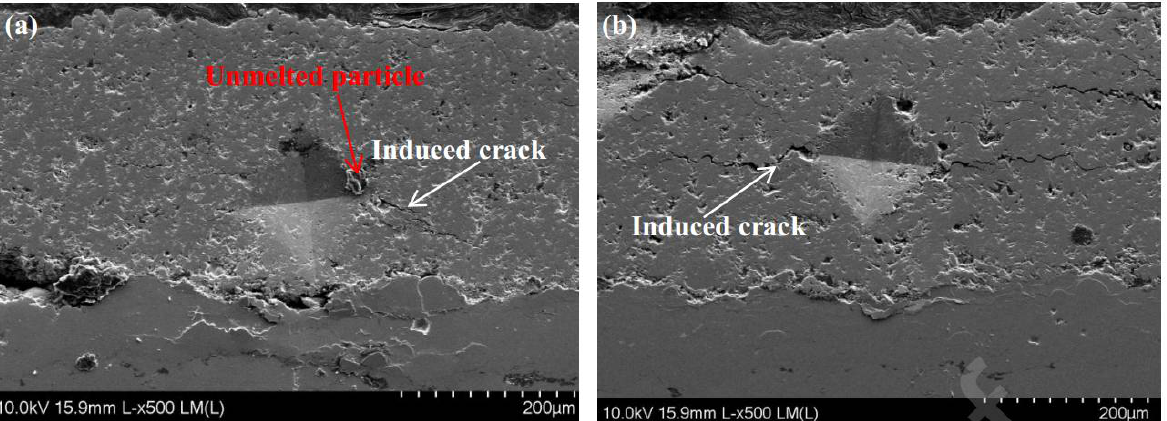
Figure 23. Morphology of indentation of ( a ) nanostructure and ( b ) traditional ceramic coatings after application (5 kgf) [148] .